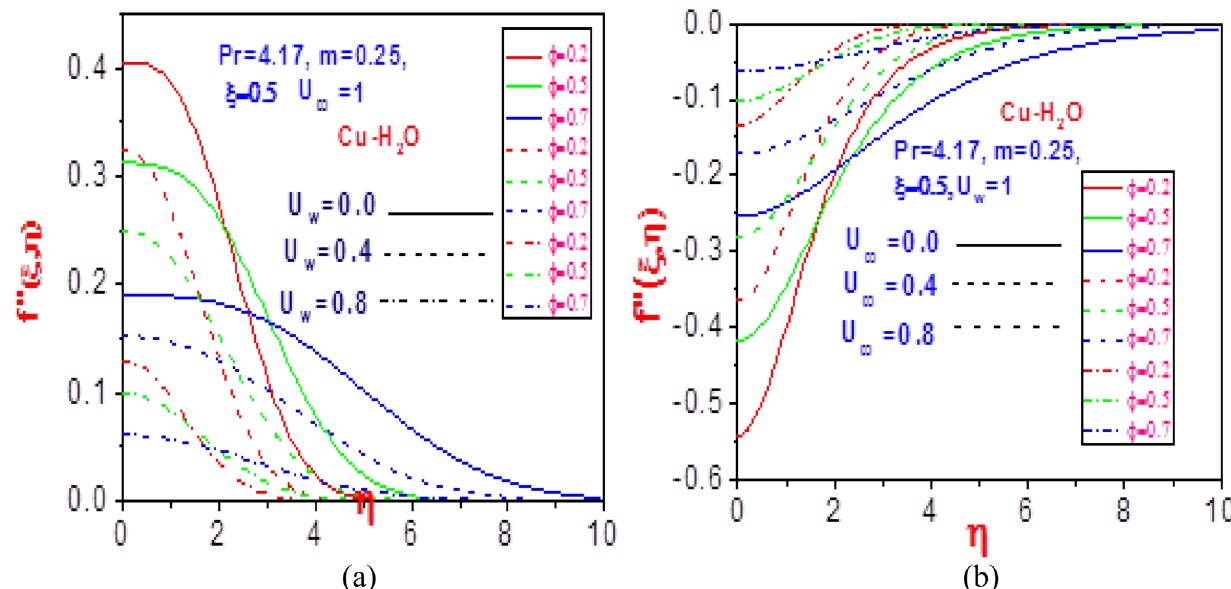
Figure 3. Profiles of velocity f ′ (ξ , η) for ( a ) different values of U ∞ with U w = 1 and ( b ) different values of U w with U ∞ = 1 .